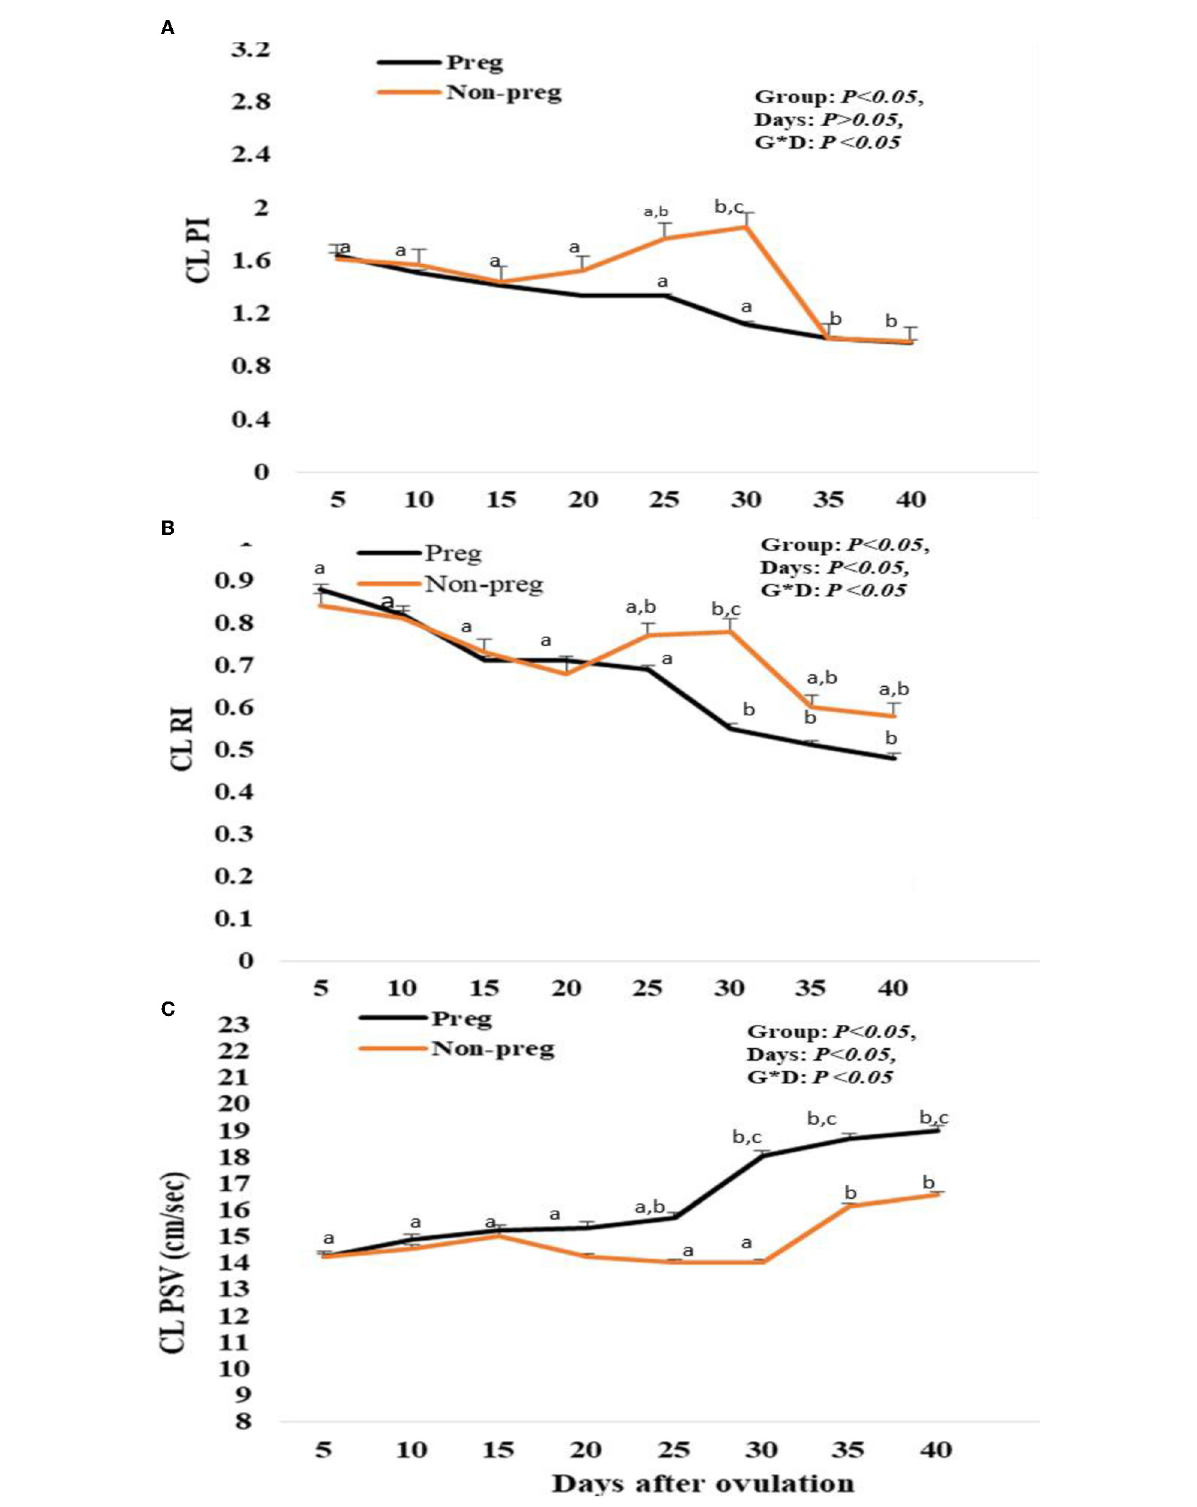
FIGURE8 Pulsatility index (PI; A ), resistance index (RI; B ) and luteal peak systolic velocity (PSV; cm/sec; C ) values presented in pregnant (Preg) and non-pregnant (Non-preg) buffalos from day 5 till day 40 after ovulation. Data are obtained as mean with standard error of mean. a,b Values are significantly different at P < 0.05 compared with day 5 in both groups, while c value is significantly different at P < 0.05 between two groups at the indicated same time